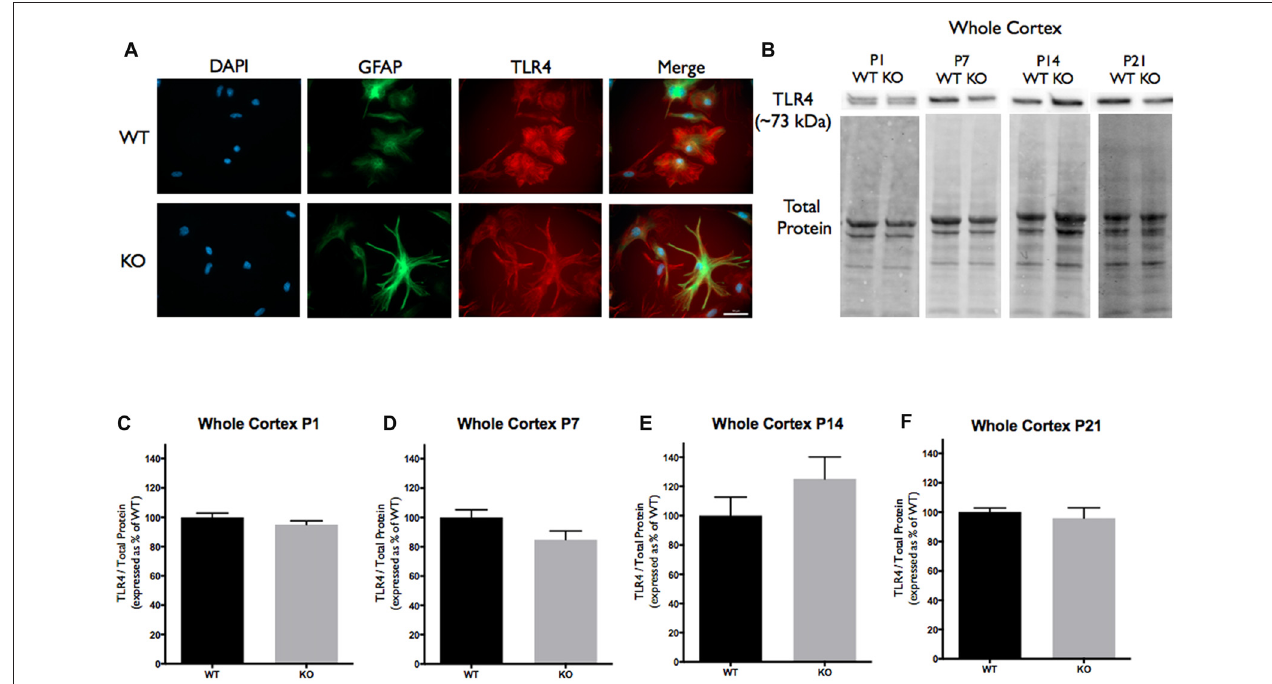
FIGURE 2 | Toll-like receptor 4 (TLR4) expression is not significantly altered in the cortex of FMR1 KO mice. (A) Cultured cortical astrocytes co-labeled with anti-GFAP (green), DAPI (blue) and anti-TLR4 (red) after 3 days in vitro . Images were obtained using a 40 × objective with a Zeiss Axioimager M2. Scale bars = 50 µ m. (B) Western blots showing TLR4 expression ( ∼ 73 kDa) in cortical samples containing 30 µ g of protein from P1, P7, P14 and P21 WT and FMR1 KO mice. Corresponding total protein was used as a loading control. (C–F) Cortical expression of TLR4 in WT (black; n = 8) and FMR1 KO (gray; n = 8) mice at P1 (six males and two females), P7 (five males and three females), P14 (six males and two females) and P21 (eight males and zero female). Representative bands were normalized to the total protein and expressed as a percentage of the average TLR4 in the WT